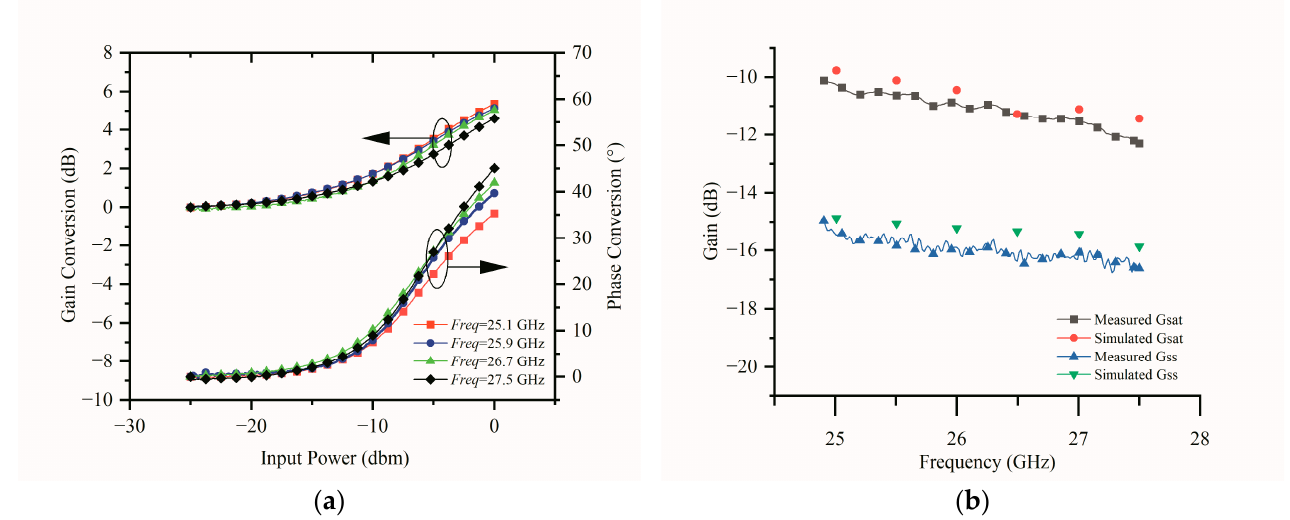
Figure 9. Measured results of ( a ) gain and phase expansion and ( b ) gain under saturation and small signal.